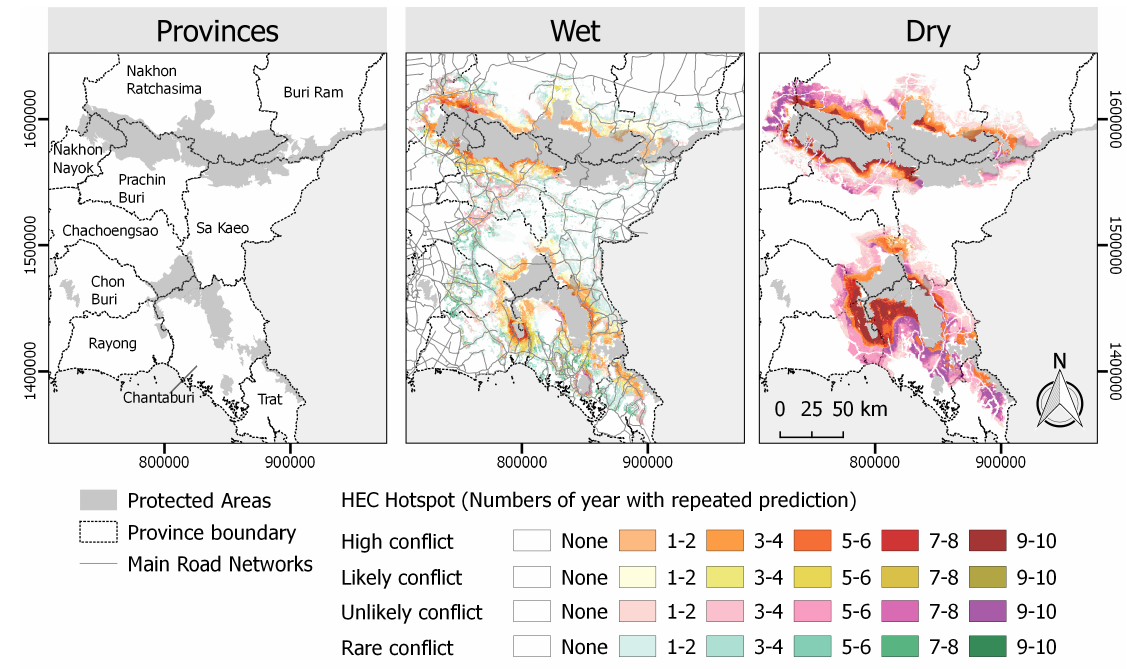
Figure 4. Conflict probability classes based on the number of years with repeated predictions of human–elephant conflict from 2009 to